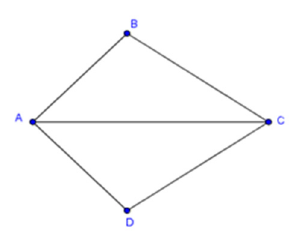
Figure 8. Figure of Task 1.